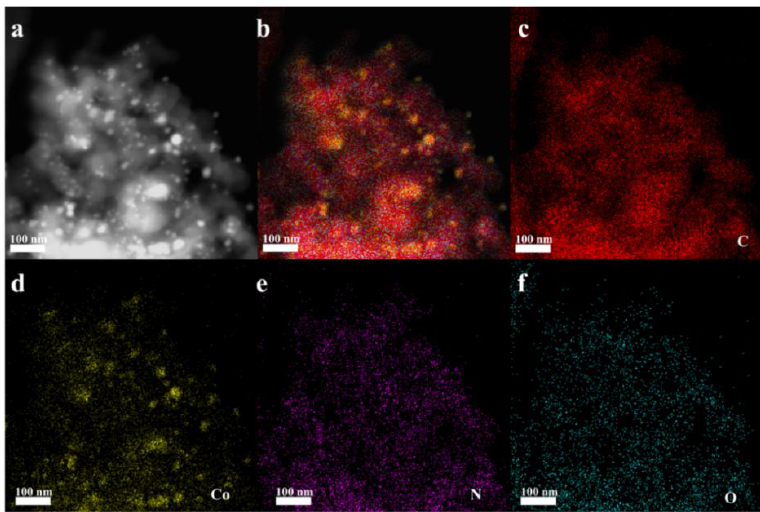
Figure 6. The high-angle annular dark field-scanning electron microscopy (HAADF-STEM): ( a ) image, and ( b – f ) mapping images of MNPC.